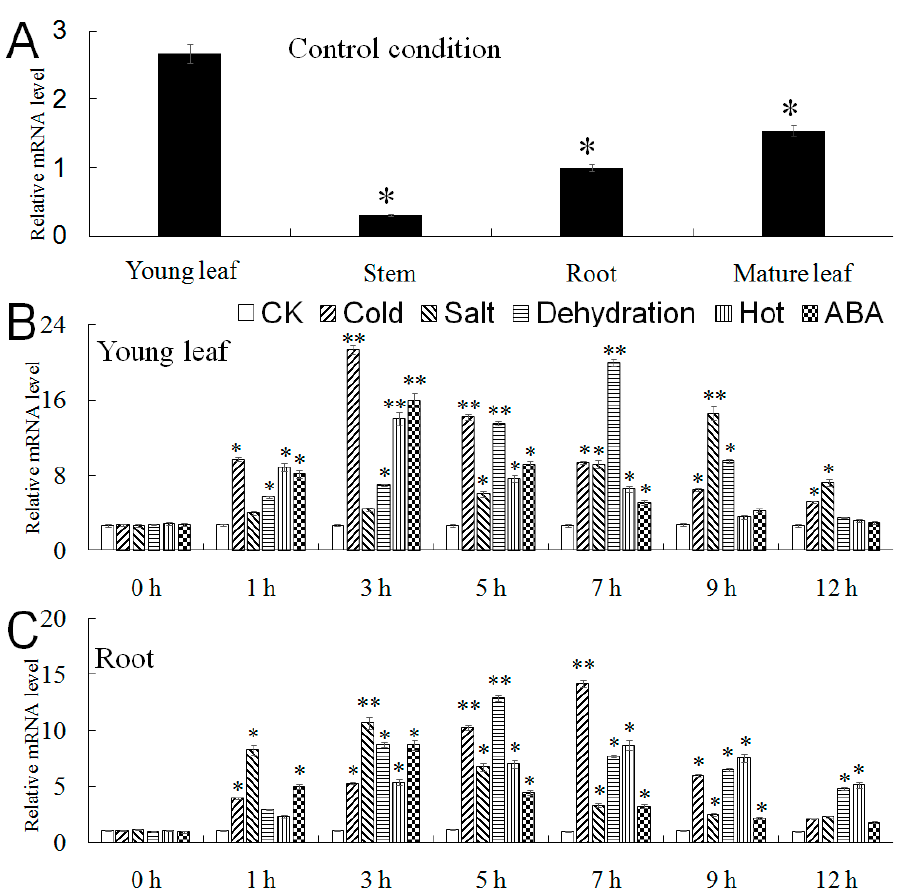
Figure 4. Time-course expression patterns of MbMYB108 in Malus baccata . ( A ) Expression patterns of MbMYB108 in young leaves (partly expanded), mature leaves (fully expanded), roots, and stems in normal condition (room temperature and normal watering). The expression level of young leaves was used as a control. Expression patterns of MbMYB108 in control condition (CK), low-tempera- ture (4 °C), high-salt (200 mM NaCl), dehydration (20% PEG), high-temperature (38 °C), and ABA (50 μ M) stress in young leaves ( B ) and roots ( C ) at the following time points: 0, 1, 3, 5, 7, 9, and 12 h. Data represent the mean of three replicates. Error bars represent standard deviation. Asterisks above error bars indicate significant differences between treatment and control (0 h) (* p ≤ 0.05, ** p ≤ 0.01). 2.5. Overexpression of MbMYB108 Improves Cold Tolerance in Transgenic A. thaliana To study the effect of overexpression of MbMYB108 on cold and drought stresses in plants, MbMYB108 was introduced into A. thaliana . Using WT and UL lines as controls, the T2 generation transgenic lines were analyzed by qPCR, and the results showed that the target gene had been integrated into the T2 generation transgenic lines (S1, S2, S3, S4, S5, S6) (Figure 5A). The three lines (S2, S4, S6) with a relatively high DNA expression level were selected to continue to cultivate to obtain T3 generation homozygous transgenic A. thaliana , which were used for subsequent research on morphological phenotype and phys- iological indexes.